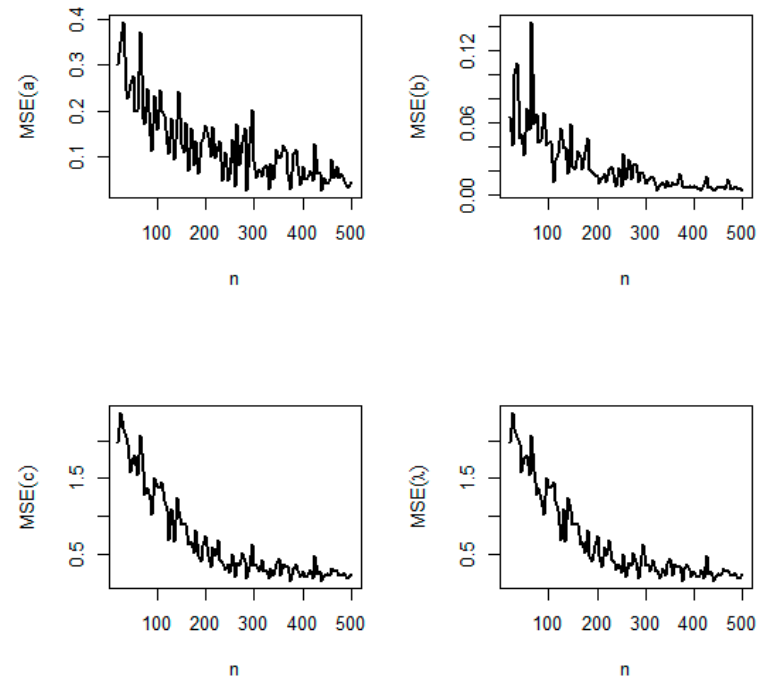
Figure 6. The MSE of the estimates of parameters of the GOLE-E distribution.